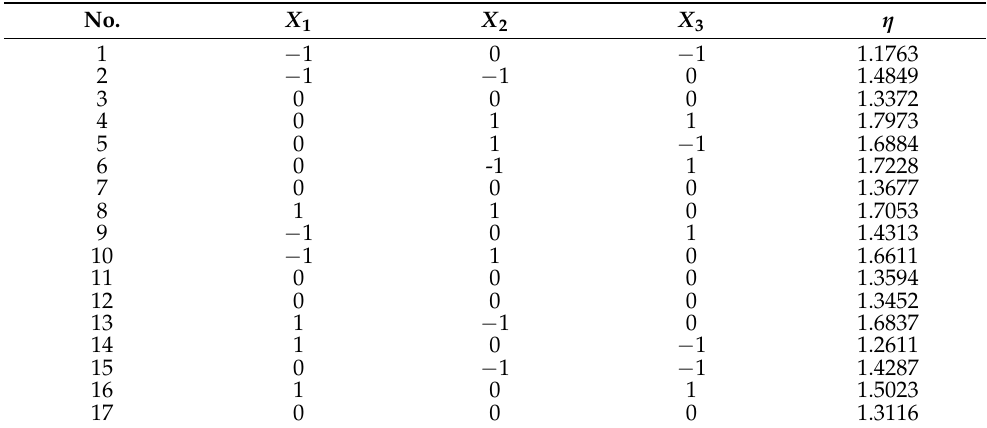
Table 3. Test plan and results.